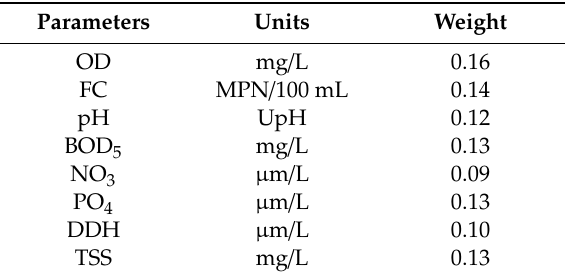
Table A7. Parameters for the ICAM PFF and their weights [28].